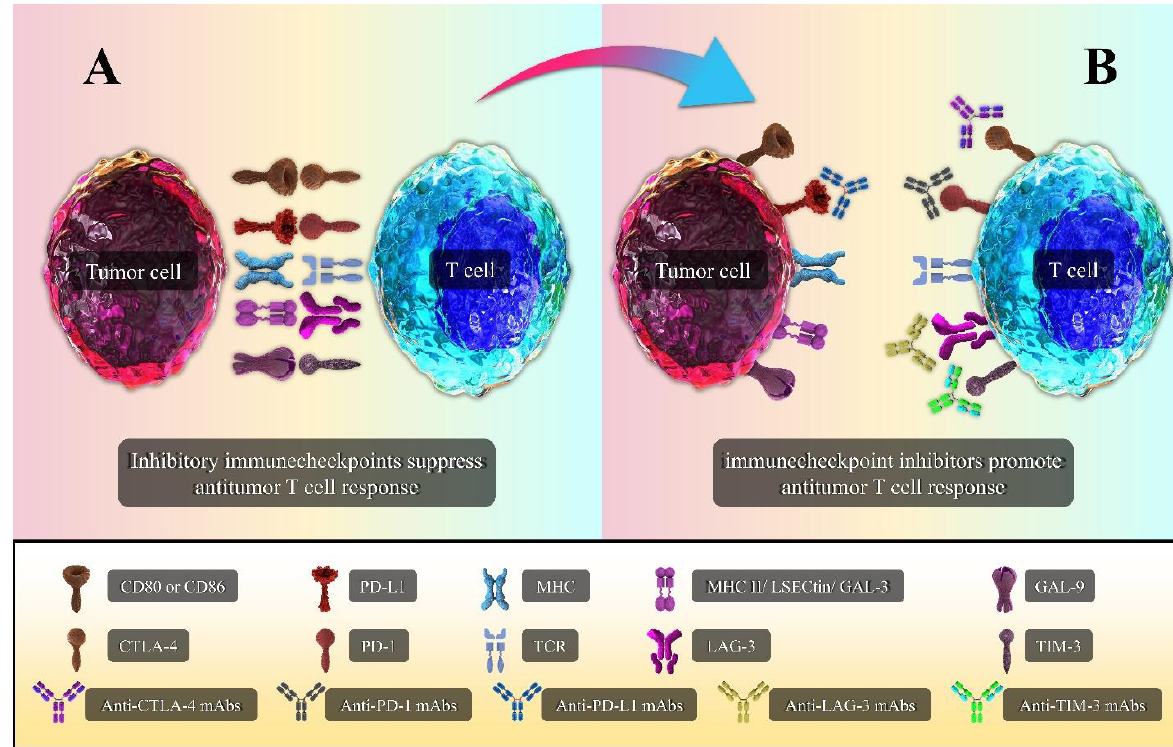
Figure 3. Targets of immune checkpoint inhibitors. ( A ) The interaction between inhibitory immune checkpoints with their ligands inhibits T cells’ antitumor function. ( B ) Engaging monoclonal antibodies (mAbs) with inhibitory immune checkpoints enhances T cells’ antitumor response by preventing T cell suppression.